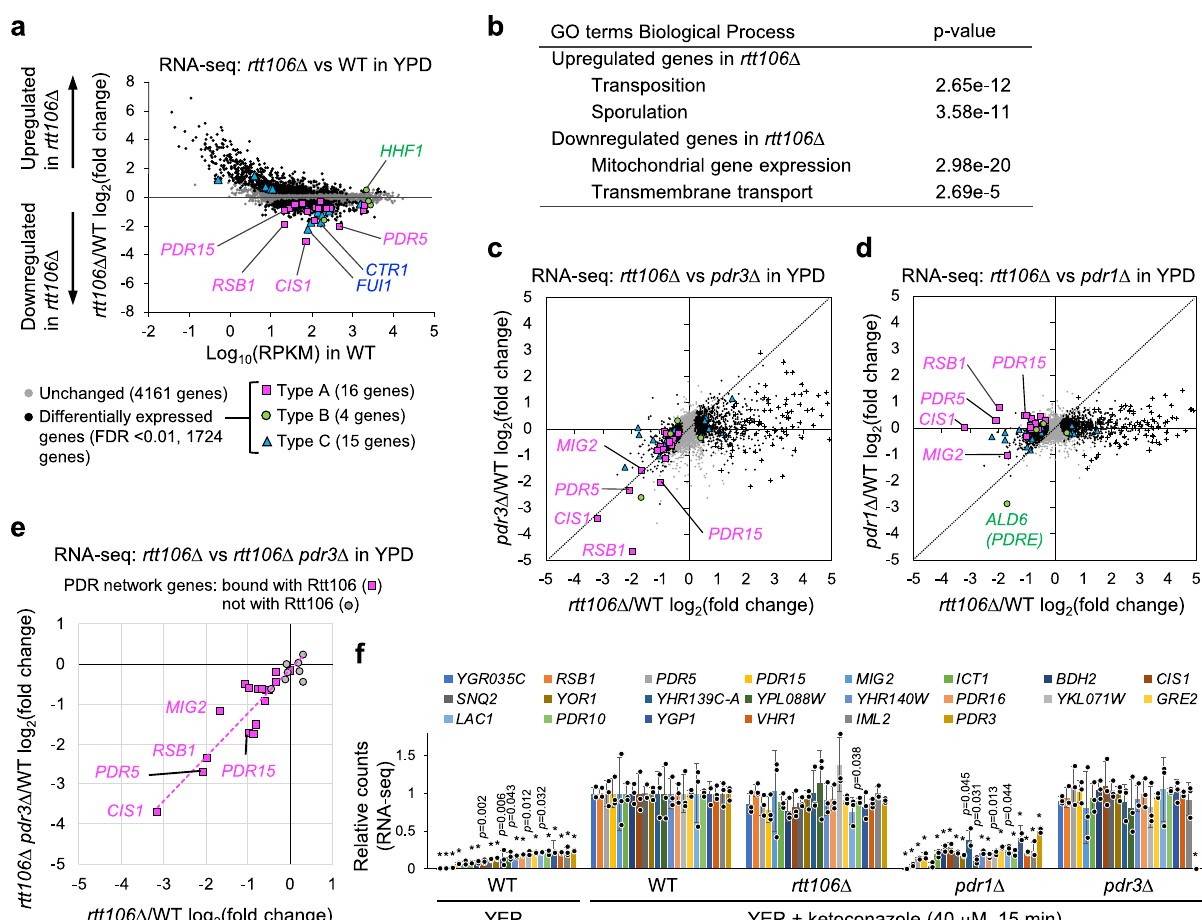
Fig. 3 Rtt106 is essential for Pdr3-mediated basal expression of the PDR network genes. a RNA-seq analysis of rtt106 Δ versus WT grown in YPD. Read counts of transcripts in rtt106 Δ divided by those in WT were plotted against RPKM (reads per kilobase of transcript per million mapped reads) in WT. Data shows mean of three biological replicates. Among 1724 differentially expressed genes (black circles, FDR < 0.01), genes in Type A (magenta squares), Type B (green circles) and Type C (blue triangles) as de fi ned in Fig. 2 are highlighted. b Gene Ontology (biological process) analysis of upregulated genes (588 genes, FDR < 0.0001) and downregulated genes (266 genes, FDR < 0.0001) in rtt106 Δ , compared to WT, in YPD. P -values were calculated by a hypergeometric distribution with Bonferroni Correction in GO Term Finder. c Correlation of changes in mRNA level of each gene in pdr3 Δ with those in rtt106 Δ grown in YPD. Colour coding as in panel a . Genes with low expression level in WT (RPKM < 1) are marked by + . d Comparison of changes in mRNA level of each gene in pdr1 Δ with those in rtt106 Δ grown in YPD. Colour cording used in panel a is used. Genes with low expression level in WT (RPKM < 1) are marked by + . e Correlation of changes in mRNA levels of the PDR network genes in pdr3 Δ rtt106 Δ with those in rtt106 Δ grown in YPD. PDR network genes with promoters bound by Rtt106 are shown by magenta squares, and those not bound by Rtt106 by grey circles. f Normalised read counts of transcripts of the PDR network genes relative to those in WT treated transiently by ketoconazole in YEP. The 22 PDR network genes whose transcripts increased more than 4-fold by ketoconazole treatment in WT are shown. Data are presented as mean values± SD. Statistical signi fi cance determined by one-way ANOVA with post-hoc Tukey HSD tests, compared to WT treated with ketoconazole. * p = 0.001. c – f Data shows mean of three biological